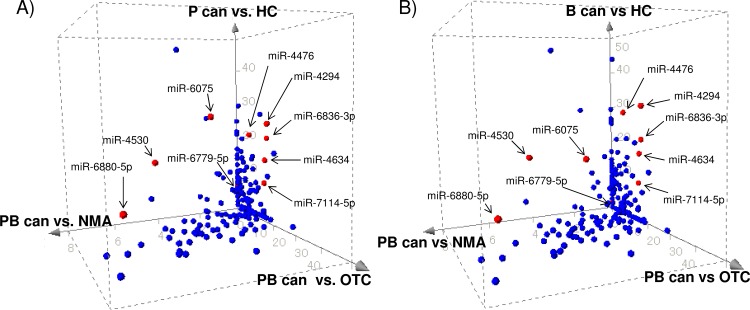
Plots of p-values in the analysis of pancreatic cancer (P can) (A) or biliary-tract cancer (B can) (B) with healthy control (HC) in z-axis, pancreato-biliary cancer (PB can) with non-malignant abnormalities (NMA) in y-axis, or pancreato-biliary cancer (PC can) with other types of cancer (OTC) in x-axis.The absolute values of the exponents of p-values on a log10 scale were plotted; therefore, miRNAs that were located in further outside are more statistically significant. The ten miRNA used in the diagnostic indices were specified.